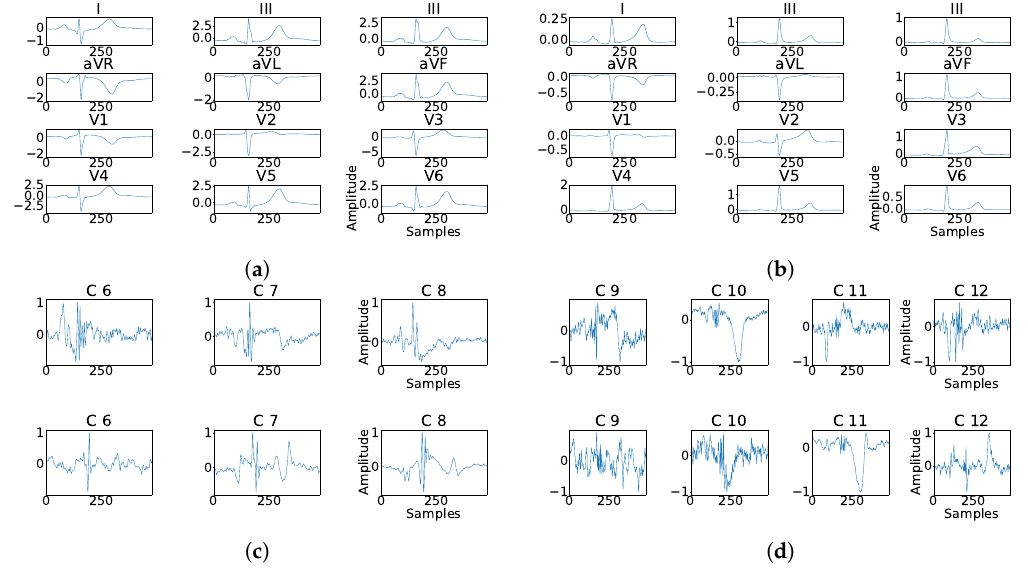
Figure 16. Example of fragmentation wave enhancement over real fragmented case. ( a ) Beat templates for each lead of real fragmented case. ( b ) Beat templates for each lead of control case. ( c ) Results of the best PCA method for the real fragmented case, in top subpanels and control case in bottom panels. ( d ) Results of the best ICA method for the real fragmented case, in top subpanels and for the control case in bottom